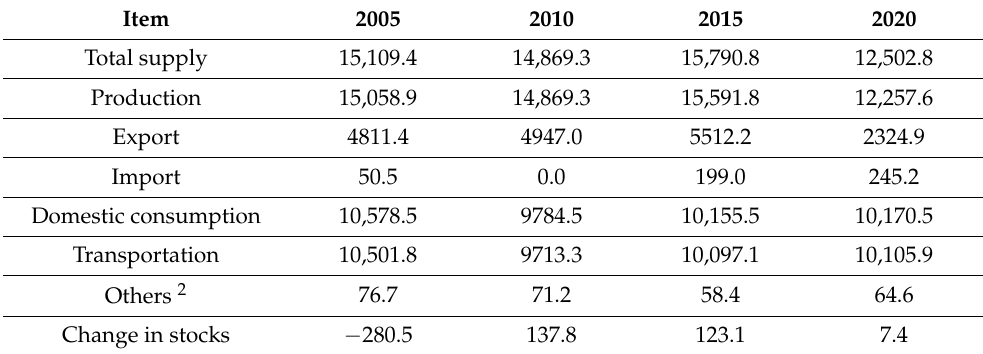
Table 1. Motor gasoline supply and consumption in Taiwan during the period of 2005–2020 1 .